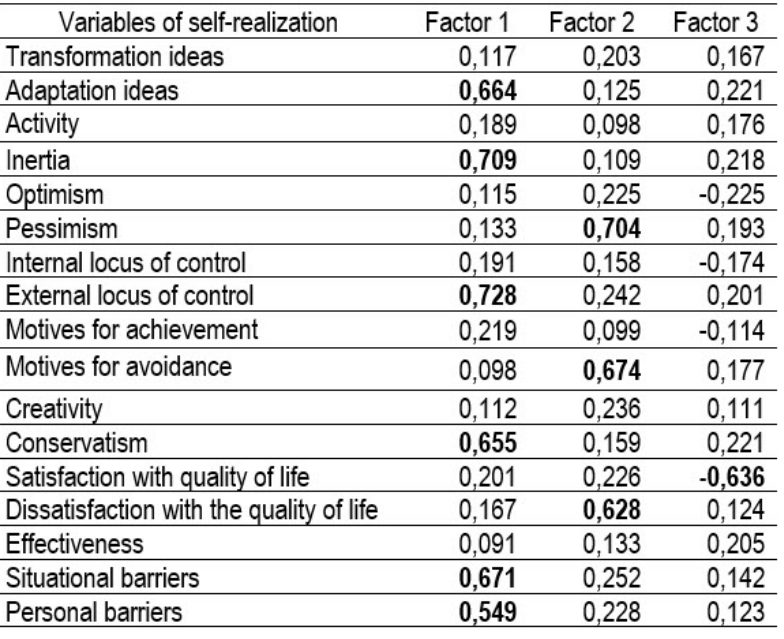
Factor structure of self-realization variables in students with a socially dependent type of self- attitude (n =